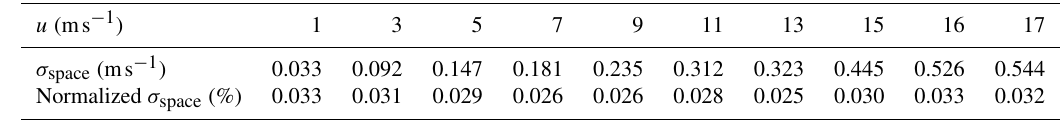
Table D1. SD σ space of five pairs of AHFO measurements (duplex configuration) per wind speed and its normalized SD. It shows that the normalized SD is ≈ 3% no matter if one takes the top, mid-top, center, mid-bottom or bottom pair.